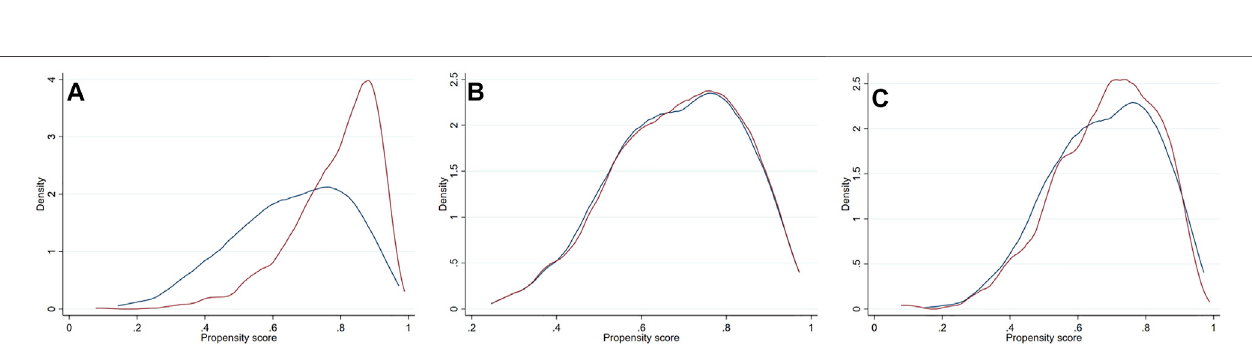
FIGURE3| Densityplotsforthedistributionofpropensityscorestrati fi edbyusageofACEI/ARBintheoriginaldataset (A) ,thePSMdataset (B) andPSMWdataset (C) . Red line = ACEI/ARB users, blue line = ACEI/ARB non-users. ACEI = angiotensin converting enzyme inhibitors, ARB = angiotensin receptor blockers, PSM = propensity score matching, PSMW = propensity score matching